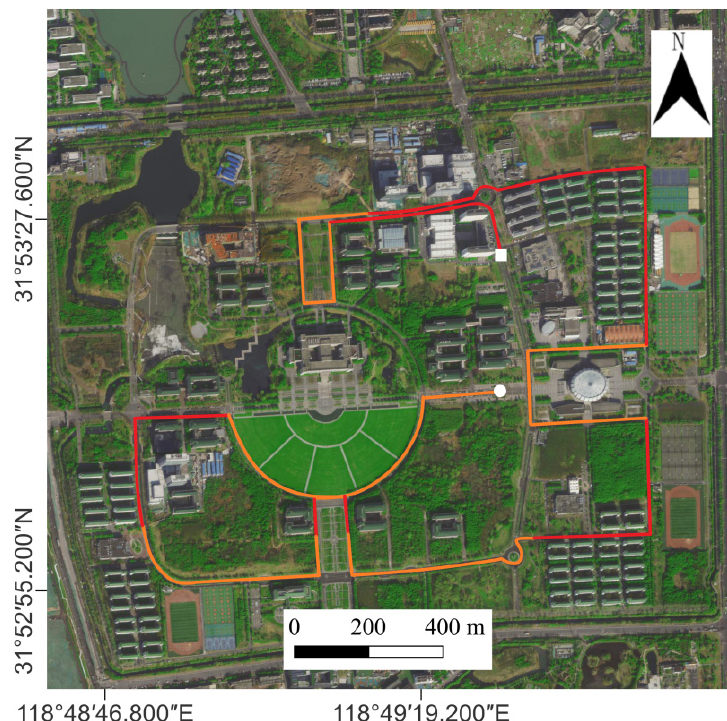
Figure 5. Vehicle driving route.